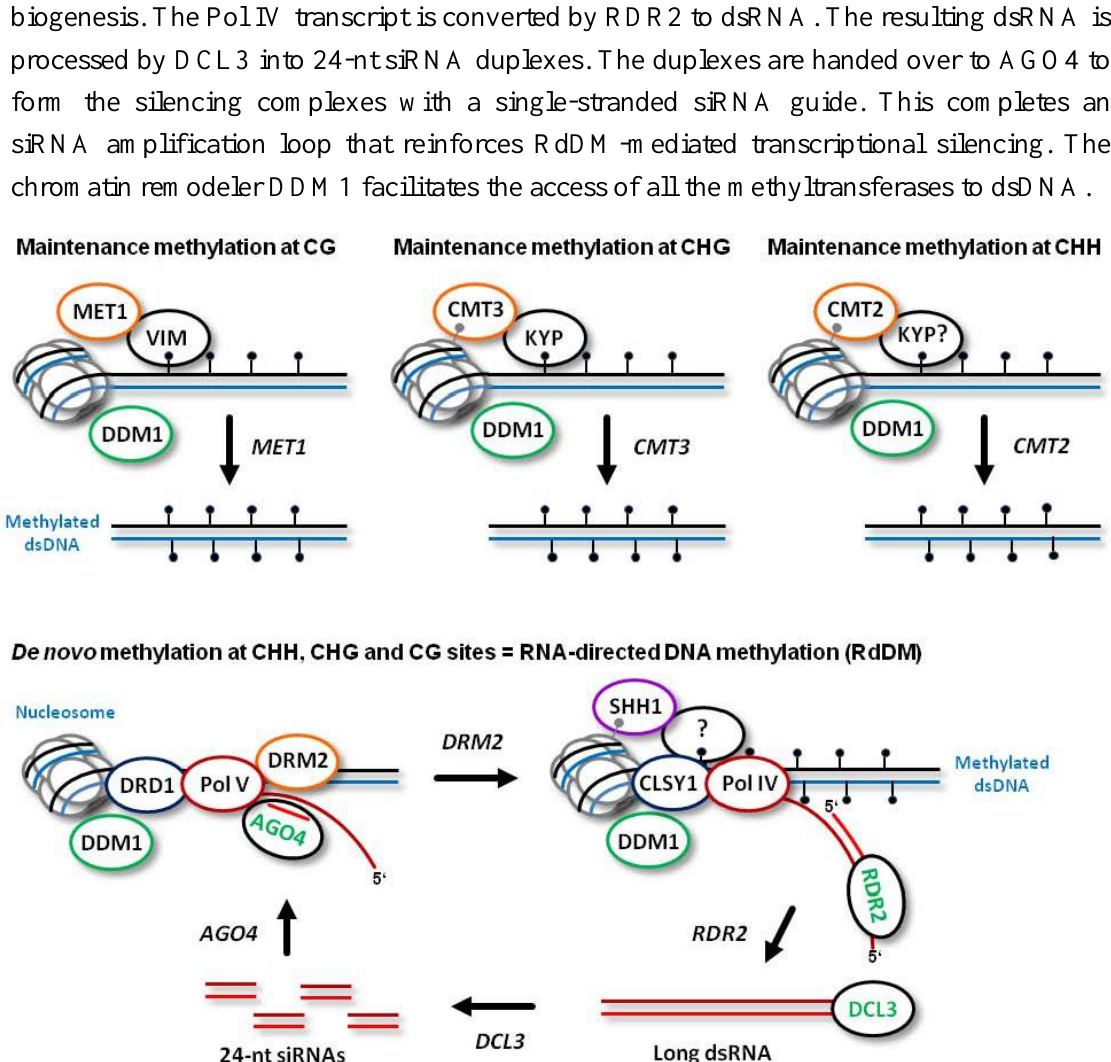
In flowering plants, cytosines in all possible sequence contexts can be methylated, including symmetric (CG and CHG, where H is A, C, or T) and asymmetric (CHH). De novo establishment of methylation at CG, CHG and CHH sites is catalyzed by DOMAINS